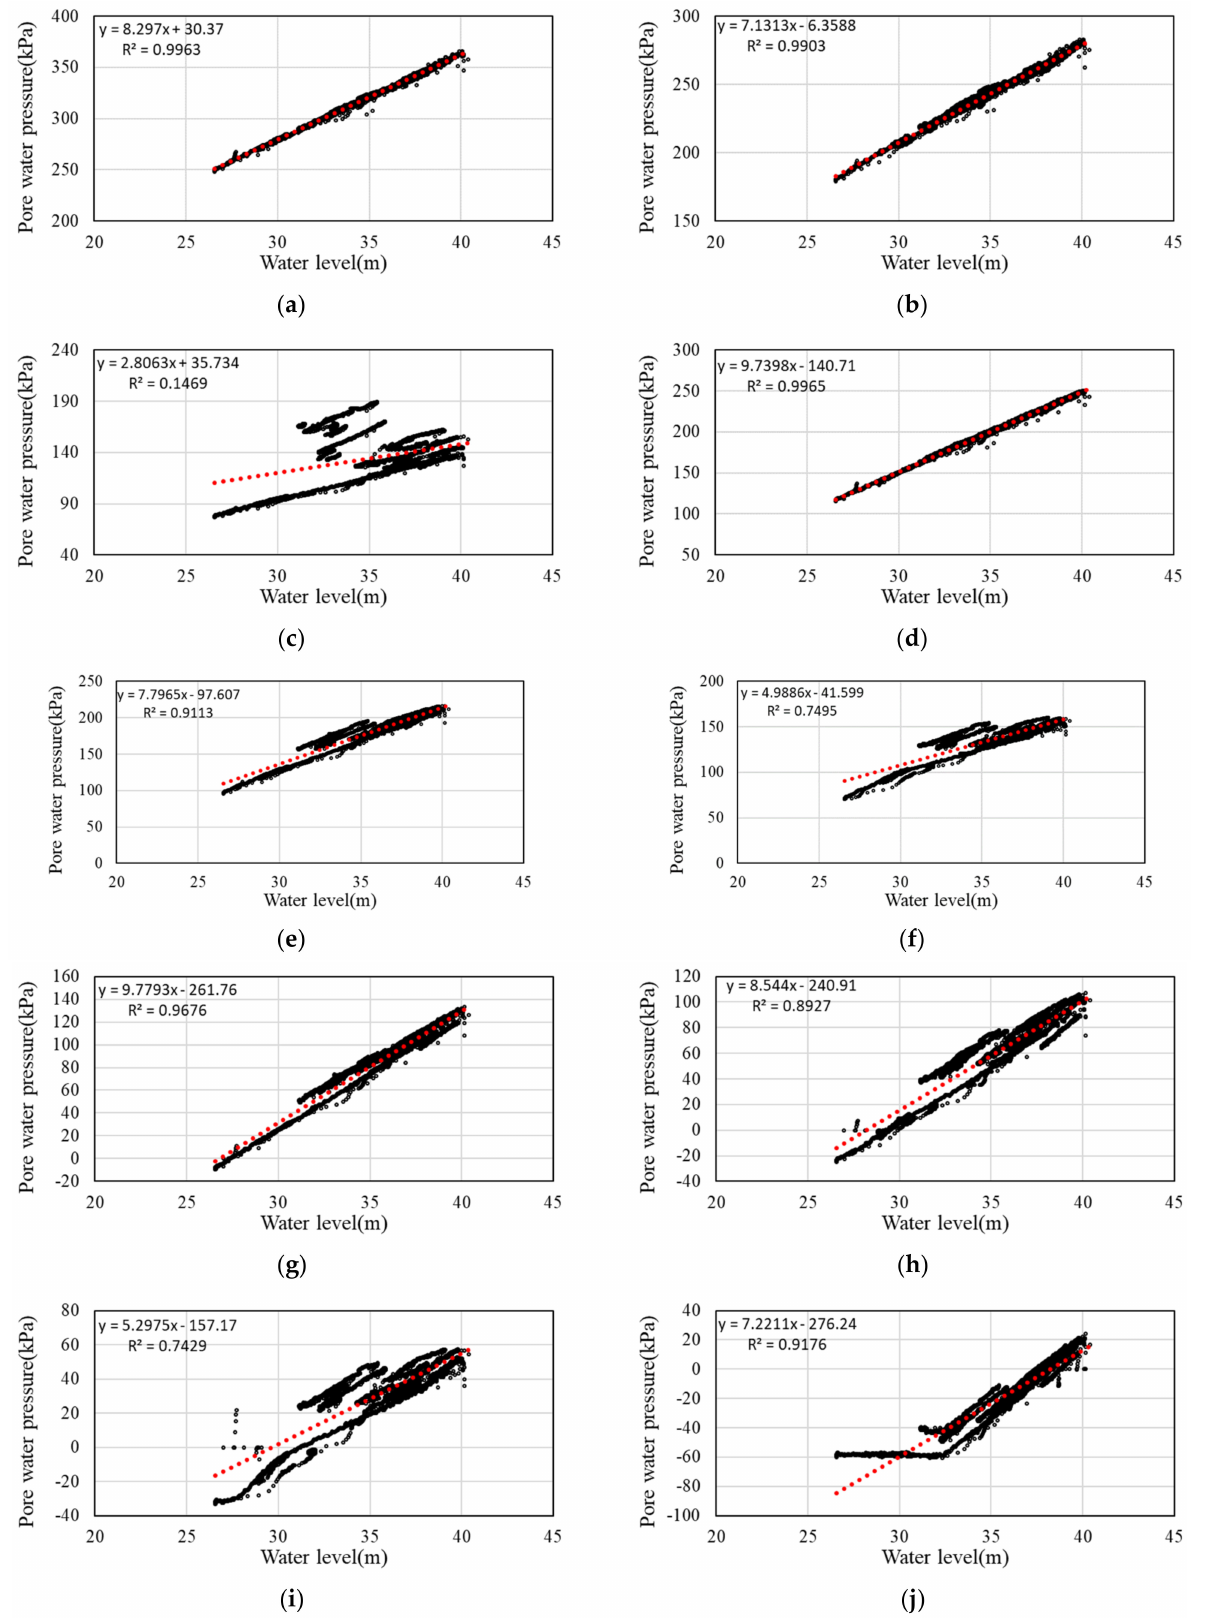
Figure 12. Regression analysis between water level and porewater pressures of Group A. ( a ) PP01; ( b ) PP02; ( c ) PP03; ( d ) PP05; ( e ) PP06; ( f ) PP07; ( g ) PP10; ( h ) PP11; ( i ) PP12 and ( j )